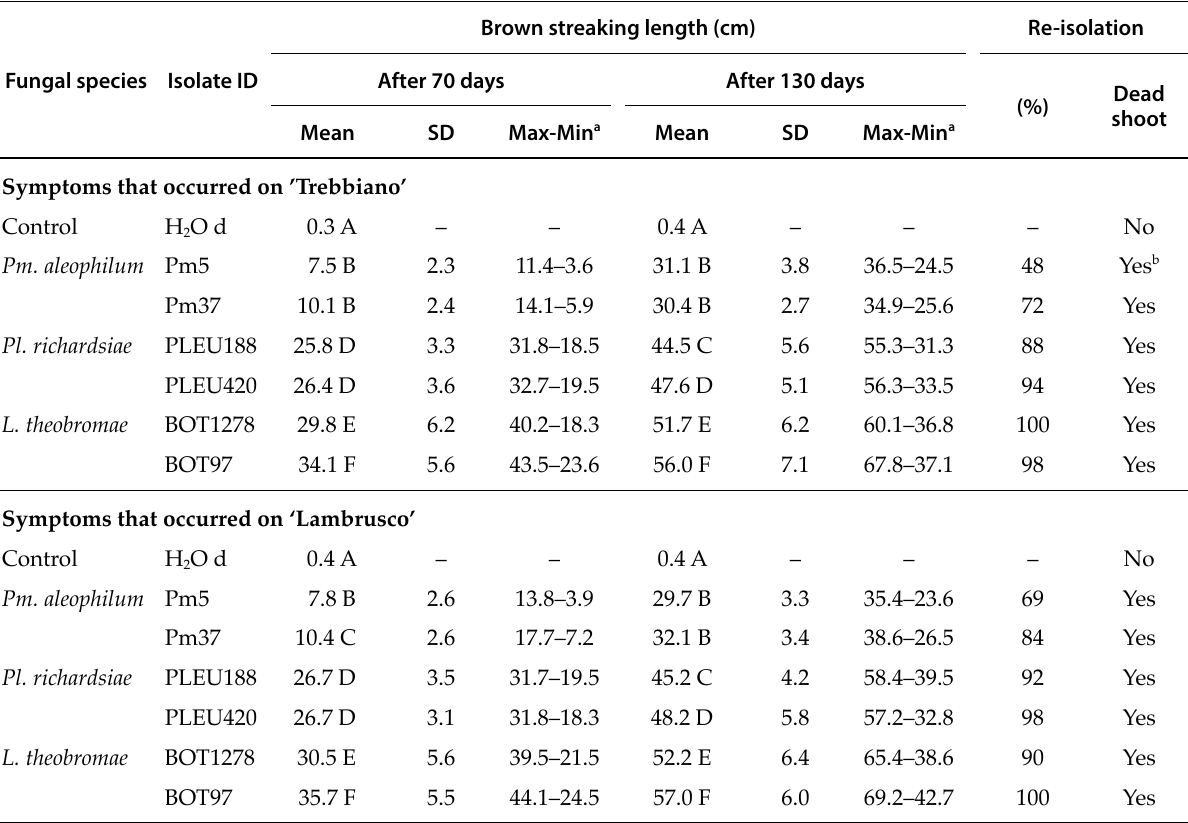
Table 3. Brown streaking lengths (Mean, SD, Max, Min) in grapevine stems from pathogenicity essays carried out with Lasiodiplodia theobromae , Pleurostomophora richardsiae and Phaeoacremonium aleophilum .